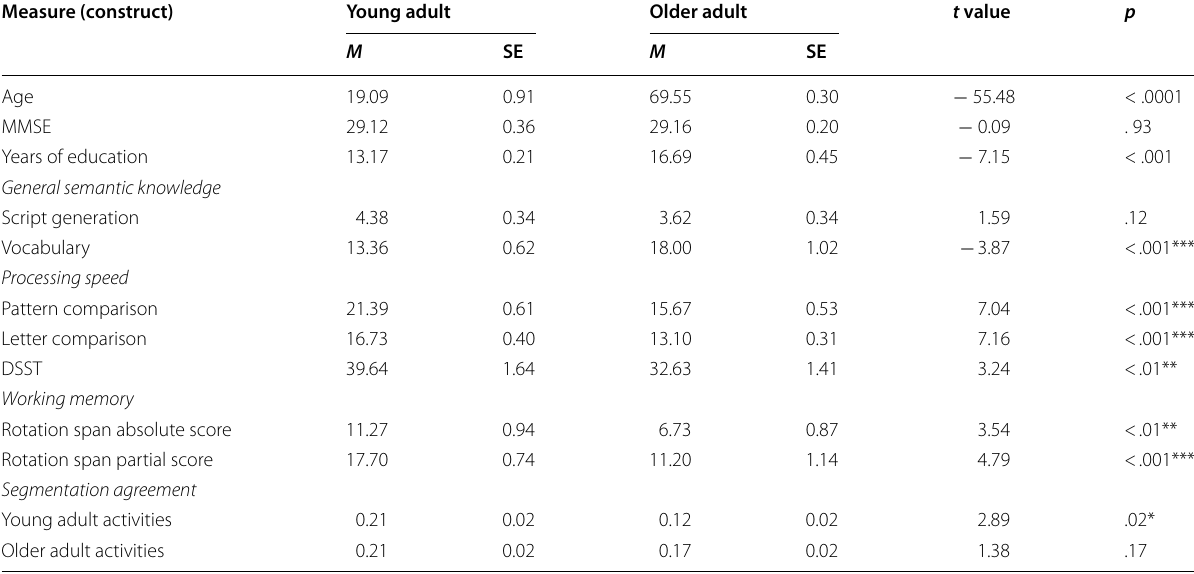
* p < .05; ** p < .01; *** p < .001; MMSE